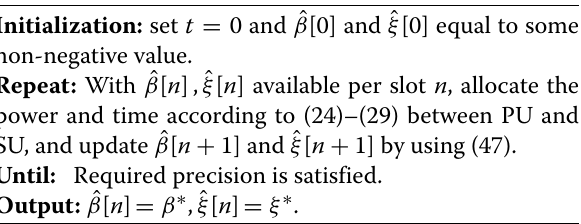
Algorithm 1 Stochastic Subgradient Iteration